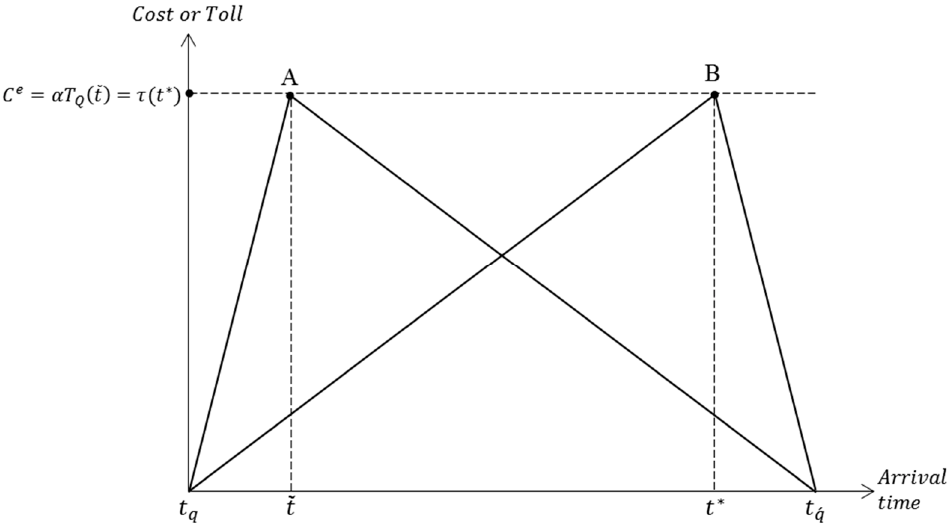
Figure 1. Queueing time costs and optimal non-queueing tolls.